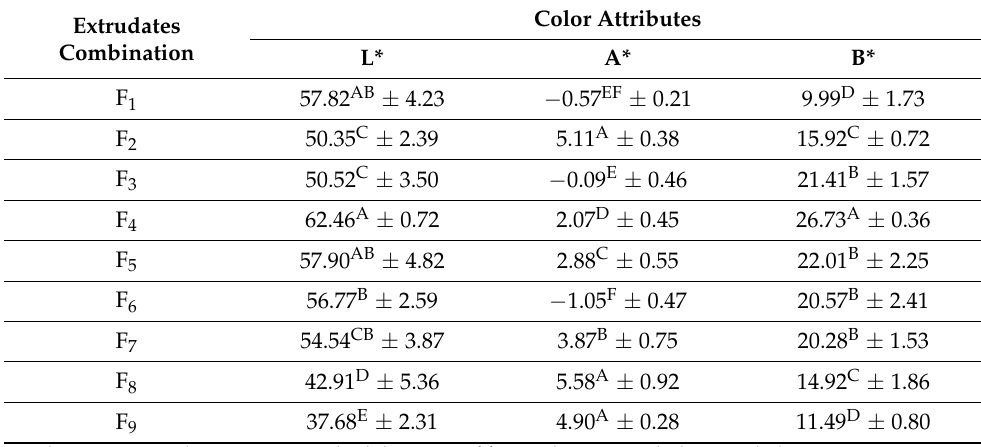
Table 7. Color attributes of neera honey incorporated